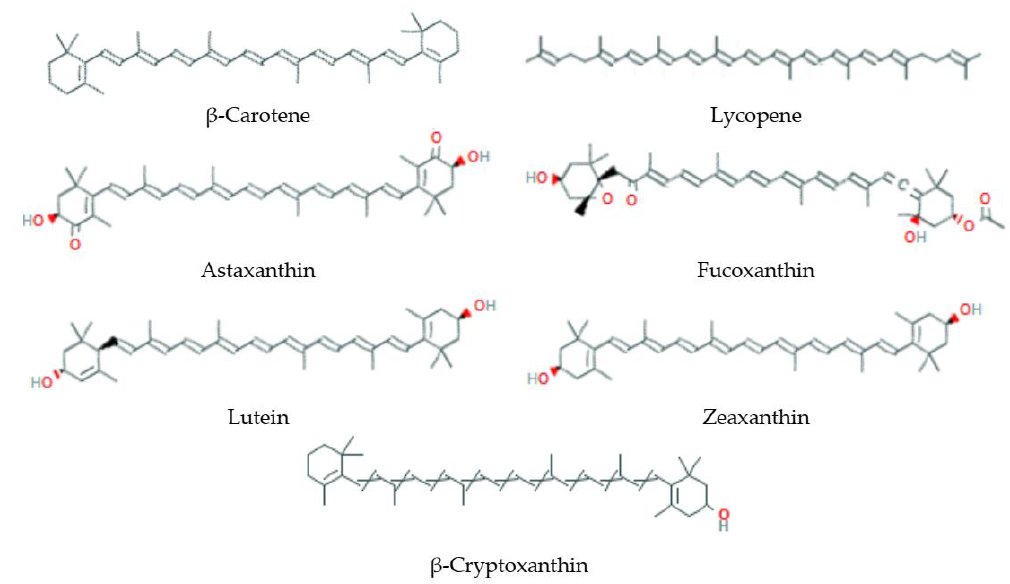
Figure 5. Some carotenoids that increase lifespan and delay age-related diseases.